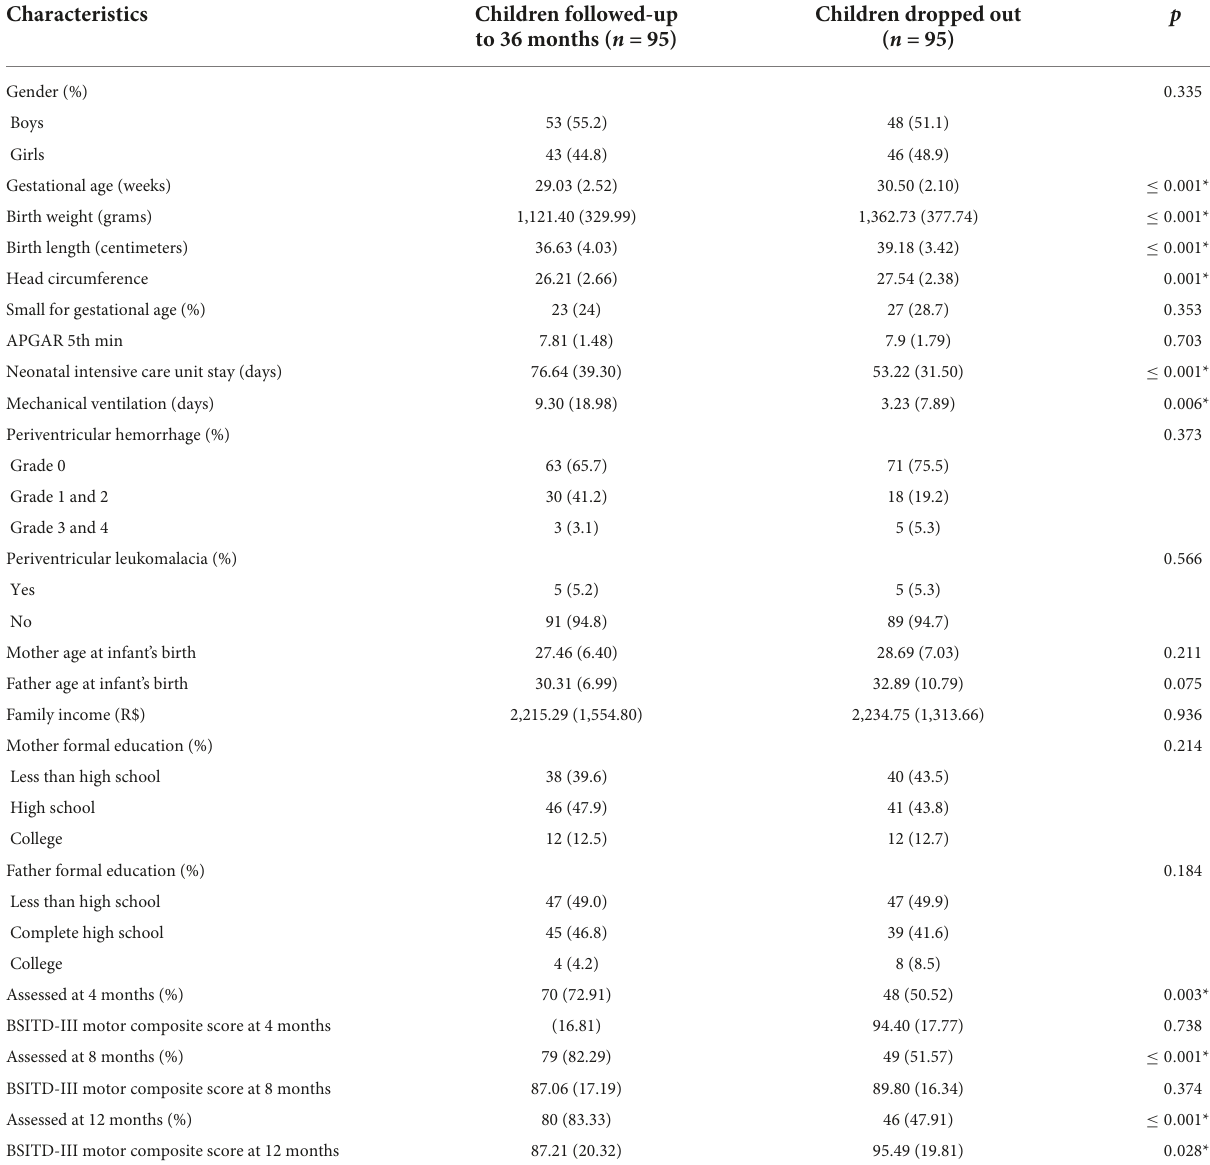
TABLE 2 Biomedical and environmental characteristics of the cohort for children follow up at 36-months and children that dropped out.